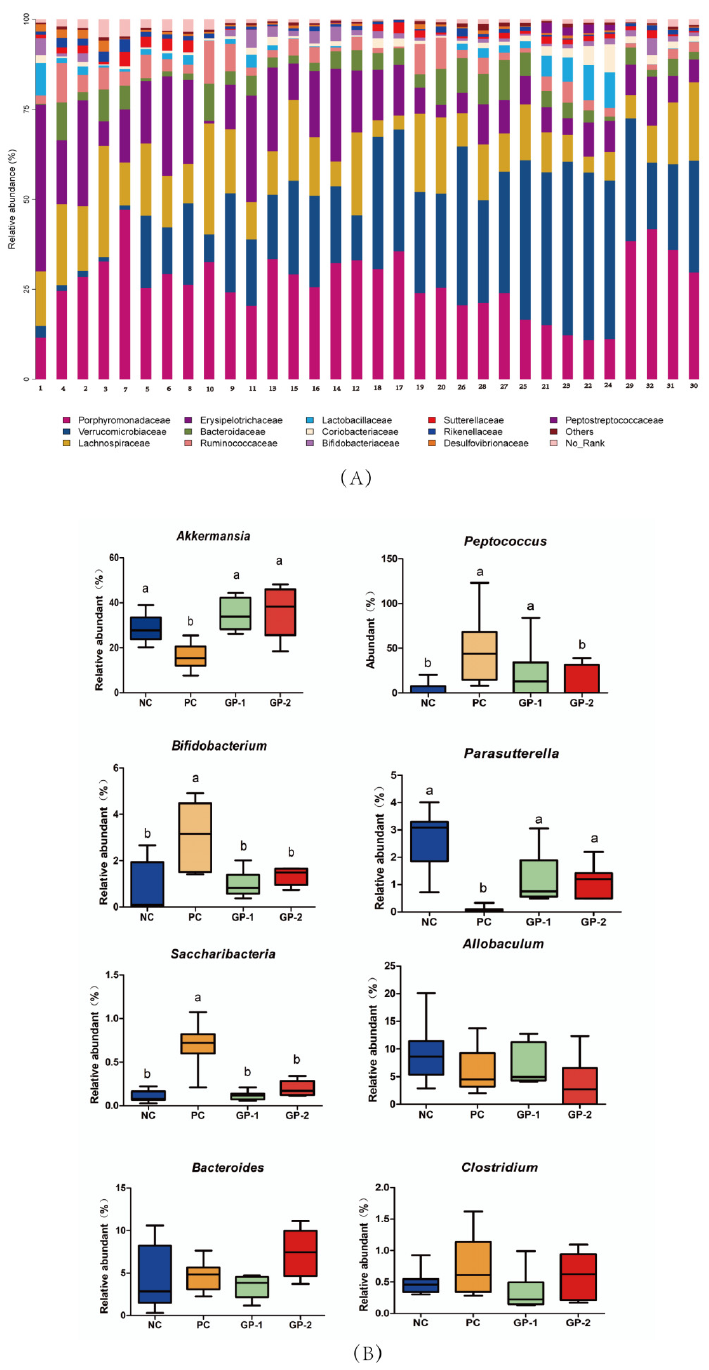
Figure 9. Gut microbial community structures in mice. ( A ) Microbial community bar plot by phylum level; ( B ) comparative analysis of relative abundances of gut microbiota at the gene level. The different letters represent significant differences between different groups ( p <